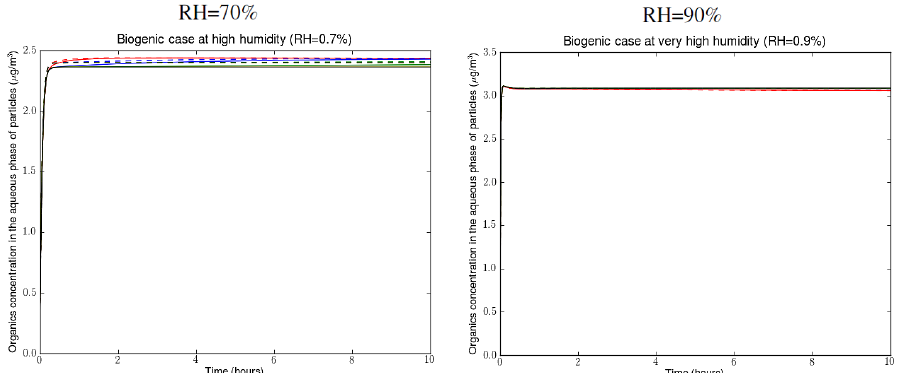
Figure 10. Evolution of concentrations in the aqueous phase for the biogenic case at various humidities, with initial concentrations equal to one tenth of the concentrations at equilibrium and 5µgm − 3 of non-volatile compounds for N layer = 5 (plain lines) and N layer = 4 (dashed lines) for several organic-phase diffusivity: D org = 10 − 19 m 2 s − 1 (red), D org = 10 − 20 m 2 s − 1 (blue), D org = 10 − 21 m 2 s − 1 (green), D org